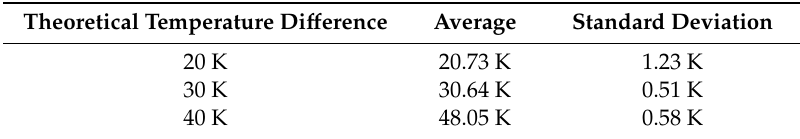
Table 7. Statistics of temperature differences.